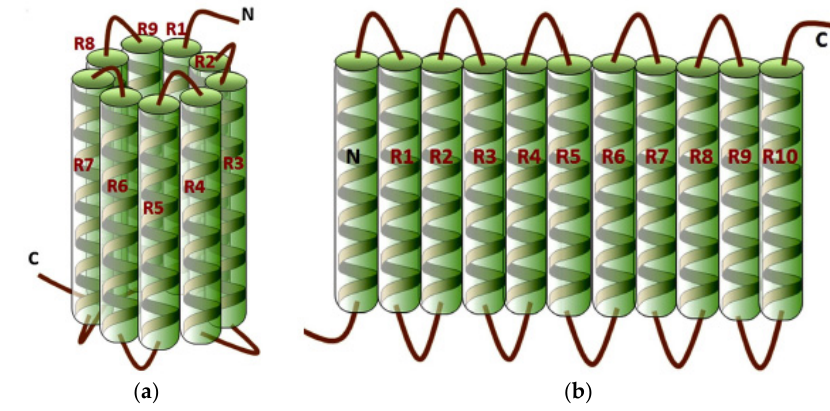
Figure 1. Two proposed three-dimensional structures of α -zein: ( a ) cylindrical model; ( b ) ribbon-like model [20]. (Reproduced from [20] with permission; Copyright 2015 Elsevier.)